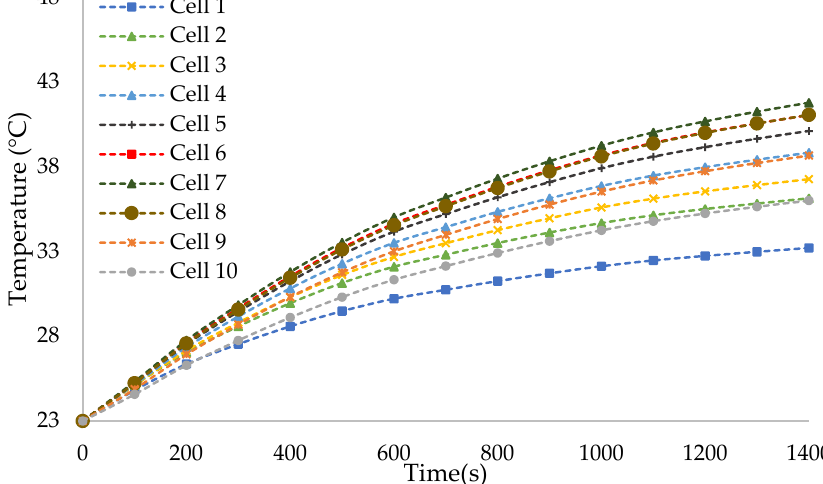
Figure 7. Temperature curves of all the LiCs in the module with inlet air velocity of V = 4 m/s.